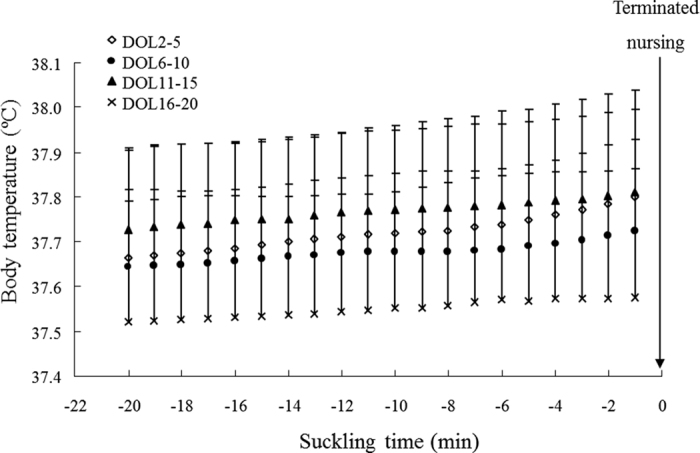
Body temperature during the last 20 minutes of nursing bouts.The data were expressed as means + S.D. for four different stages of lactation. Day of lactation (DOL) 2–5 (open-diamond), DOL 6–10 (closed-circle), DOL 11–15 (closed-triangle) and DOL 16–20 (cross). Sample sizes (n) were 18 female mice in early lactation (DOL 2–10) and 26 female mice in late lactation (DOL 11–20) although the means were obtained from 334, 420, 542 and 537 nursing bouts in DOL 2–5, DOL 6–10, DOL 11–15 and DOL 16–20, respectively.